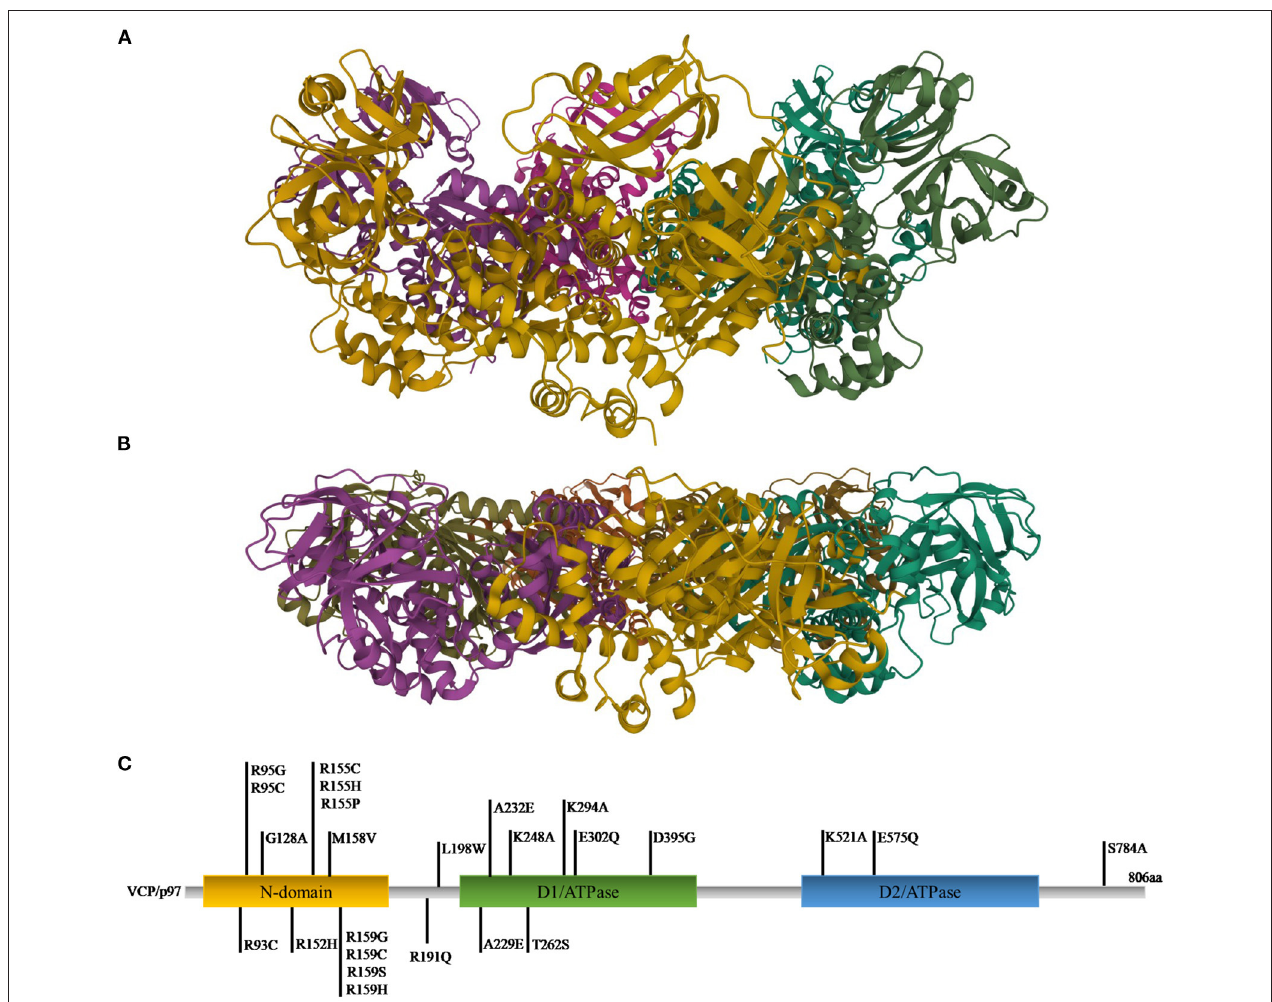
FIGURE 1 | Ribbon diagram representations of X-ray structures of VCP in the up (A) and down (B) states [PDB ID code 4KO8 (122) for the up state and 1E32 (123) for the down state]. (C) Gene representation with the indication of the three main domains and the relative mutations (C-terminal domain was omitted).